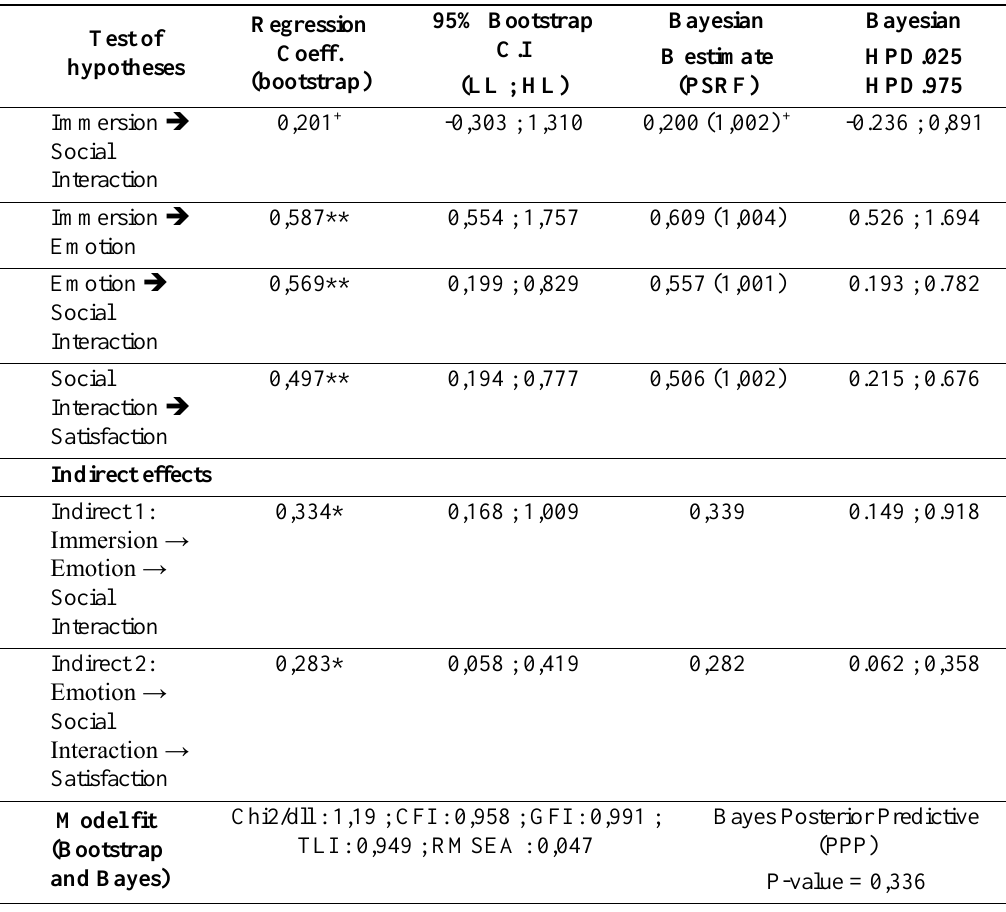
Table 2: Model Fit and Test of Hypotheses Using Bootstrap and Bayesian